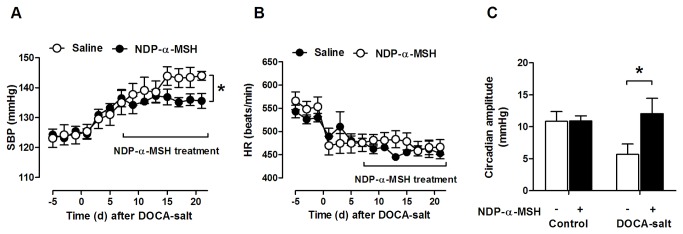
Telemetric measurements of blood pressure in saline- and NDP-α-MSH-treated DOCA-salt mice.Systolic blood pressure (A) and heart rate (B) in control and DOCA-salt treated mice measured by radiotelemetry. Data represent 24 h mean values of SBP and HR. (C) Circadian amplitude, the difference between night- and day-time SBP, at baseline and at day 21 after the beginning of DOCA-salt treatment. * P < 0.05 versus saline-treated mice. Data are mean ± SEM of five mice per group.